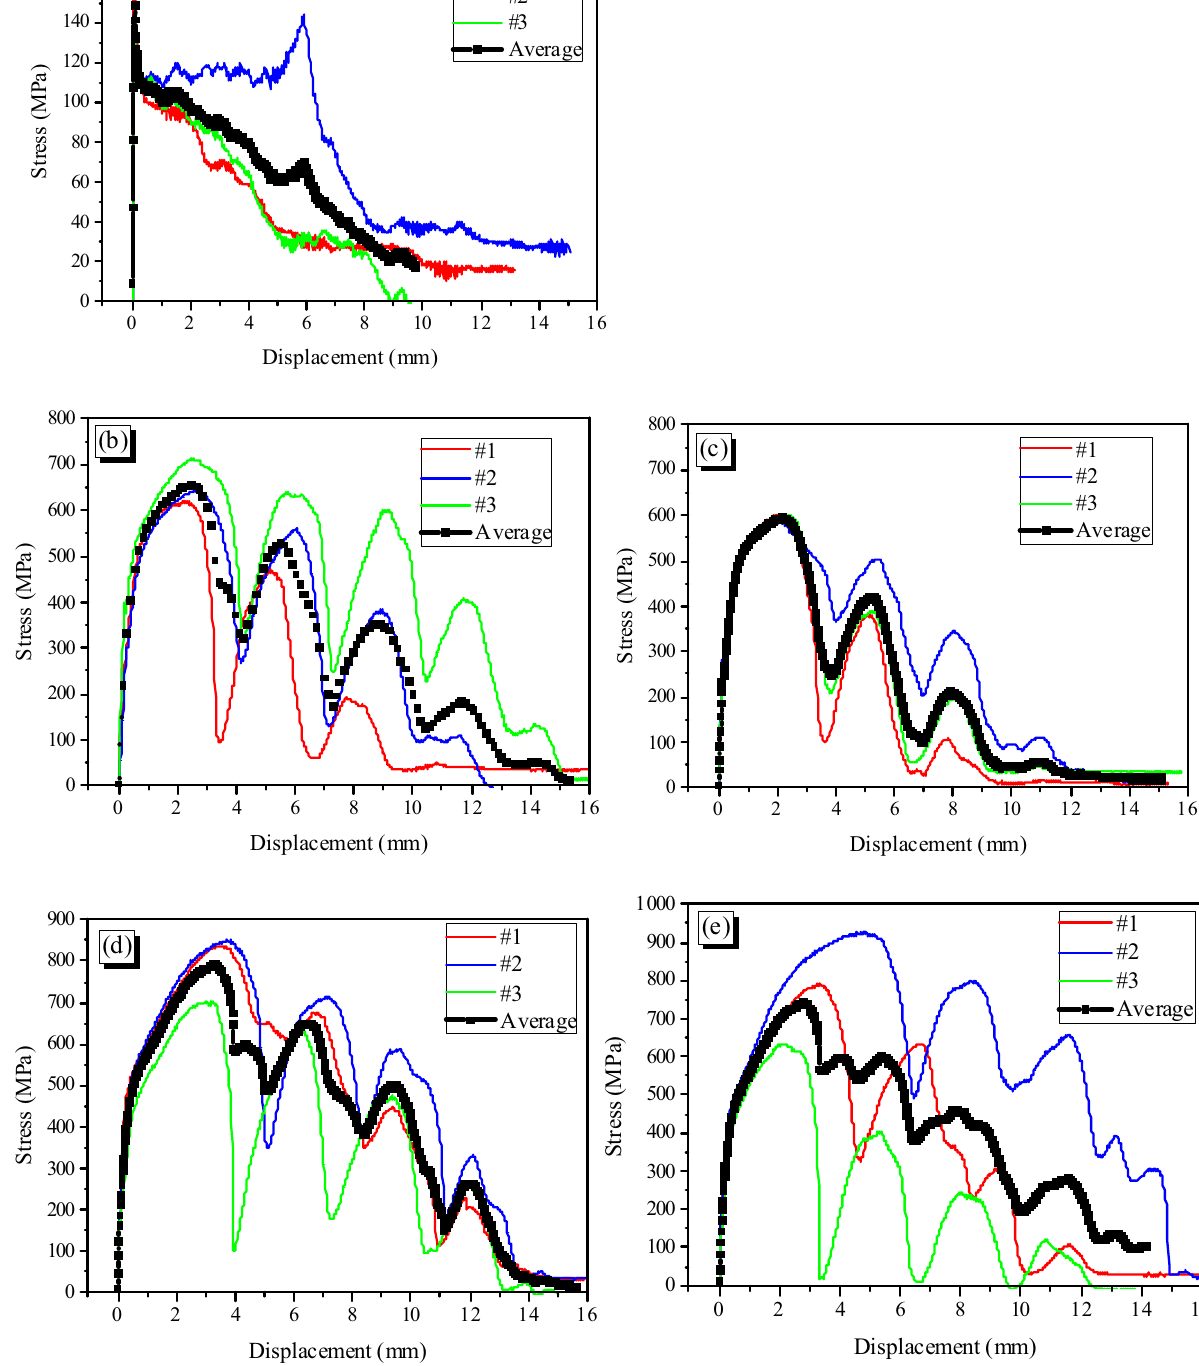
Figure 6: Pullout stress – displacement curves of the fi bers in the heating case: ( a ) ST - H, ( b ) CR1 - H, ( c ) CR2 - H, ( d ) CR3 - H, and ( e ) CR4 -